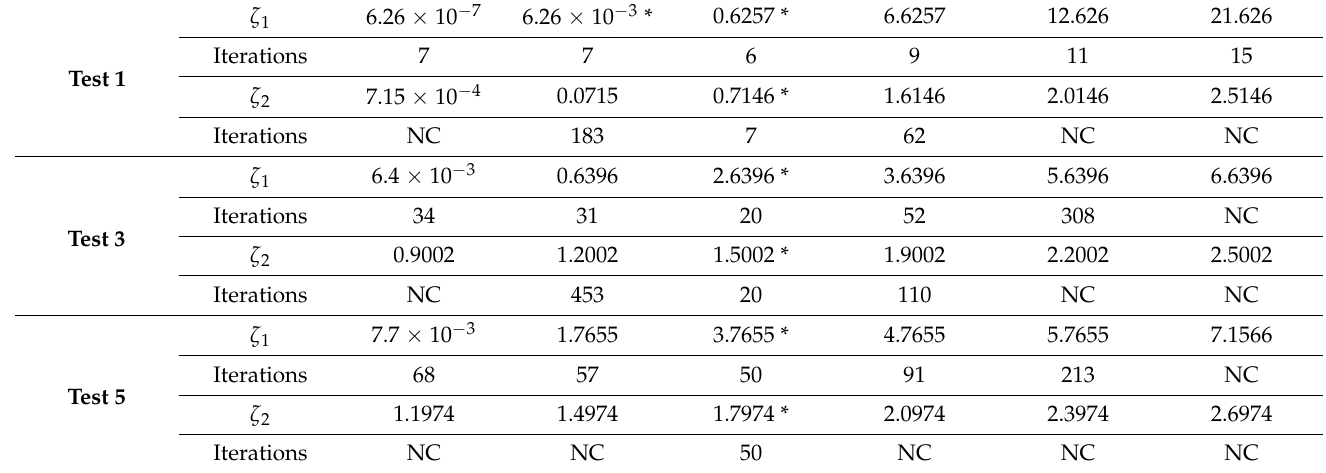
Table 7. Sensitivity of load flow solution to the values of ζ 1 and ζ 2 for the six-bus system.